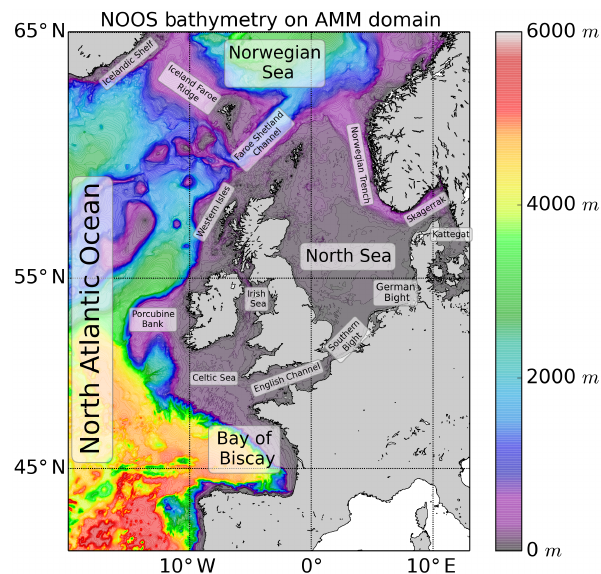
Figure 1. NOOS bathymetry for the AMM